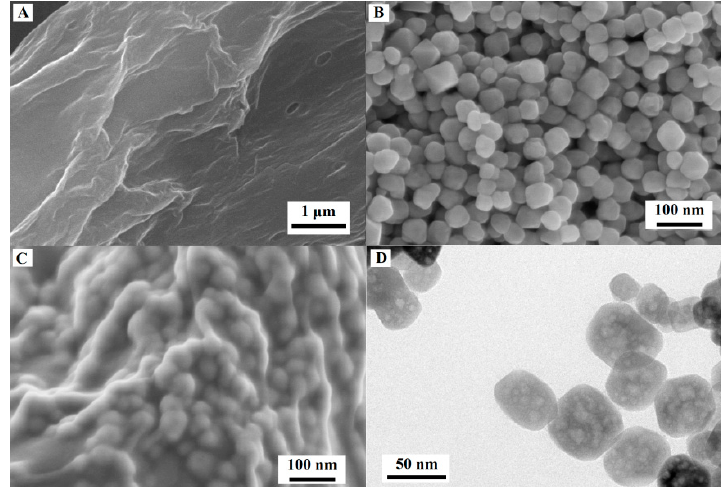
Figure 1. Scanning electron microscope (SEM) images of graphene oxide (GO) ( A ), Amine-functionalized Fe 3 O 4 nanoparticles (NH 2 -Fe 3 O 4 NPs) ( B ) and NH 2 -Fe 3 O 4 -electrochemically reduced graphene oxide (ErGO) nanocomposites ( C ) and the Transmission electron microscope (TEM) image of NH 2 -Fe 3 O 4 NPs ( D ).